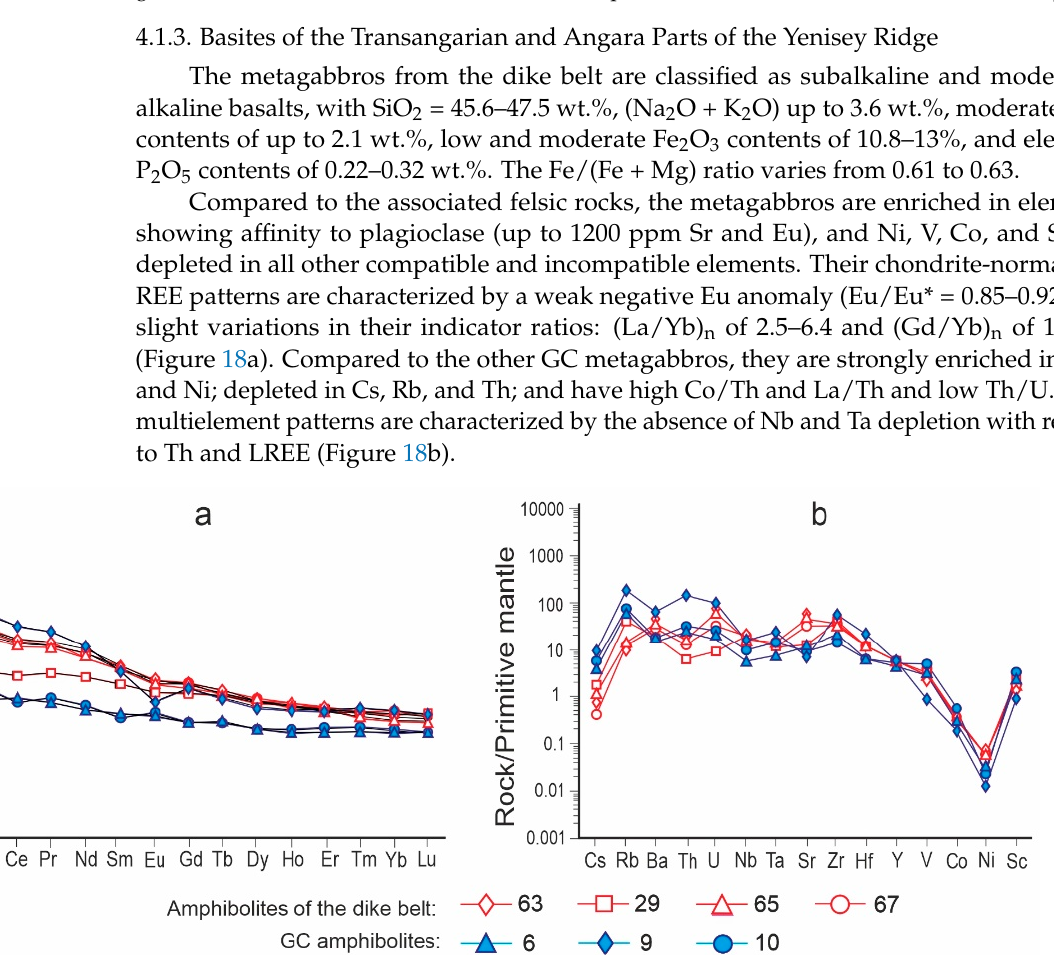
Figure 18. Chondrite-normalized REE patterns [98] ( a ) and primitive mantle-normalized spider- grams [99] (b ) for the GC metabasites. Numbers in symbols correspond to the sample numbers.